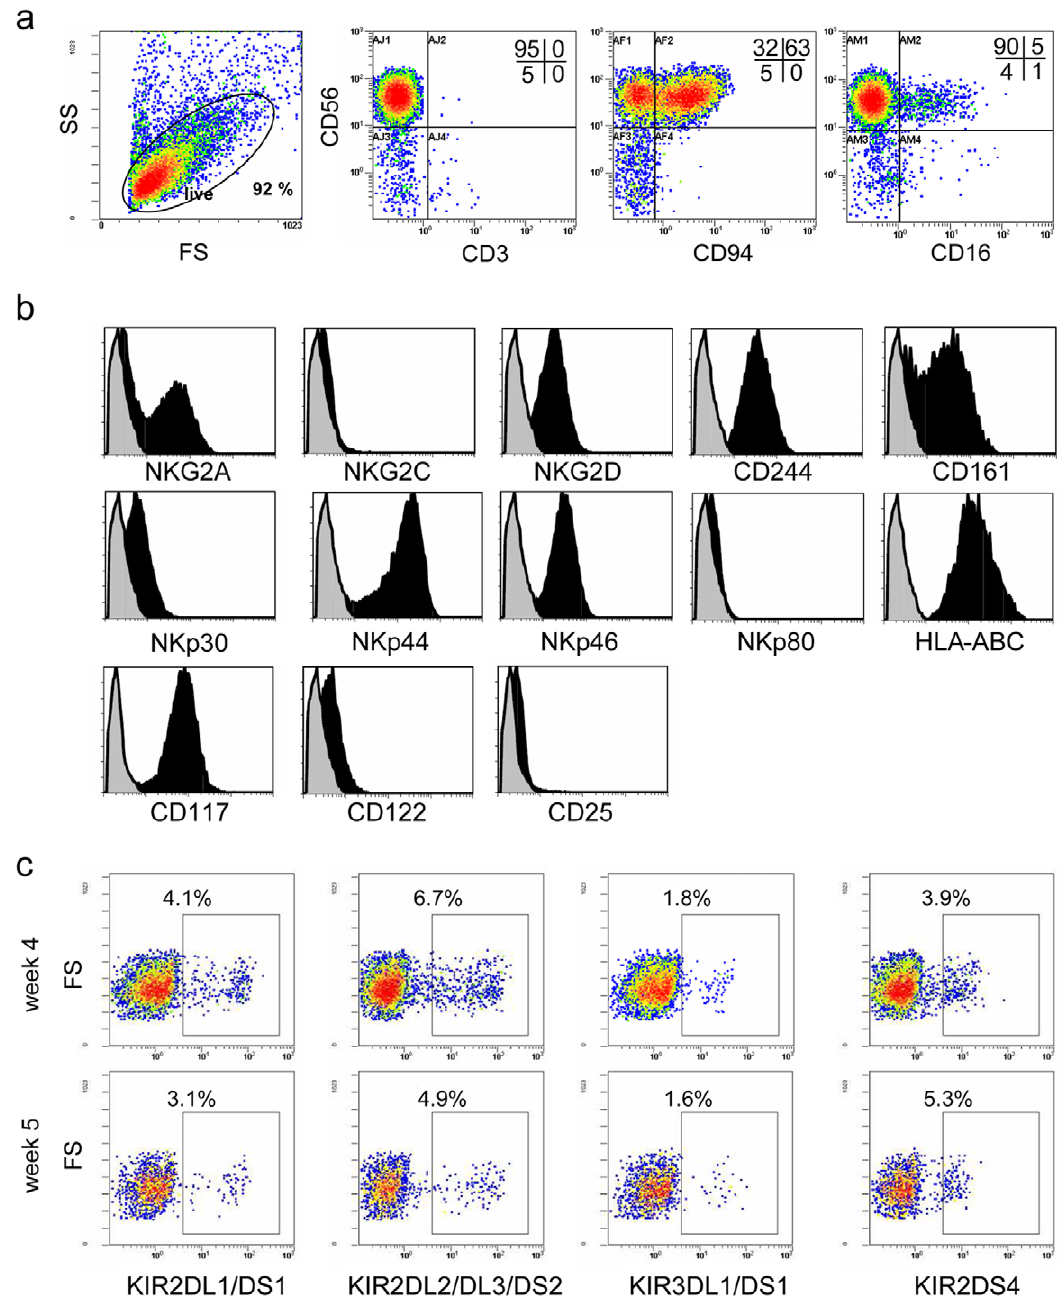
Figure 4. Phenotypical profile of exvivo -generated NK cells using Method II with GBGM. ( a ) Flow cytometric analysis of a representative NK cell product generated from CD34 + UCB progenitor cells. Cells at 5 weeks of culture were analyzed for expression of CD56, CD3, CD94 and CD16. ( b ) Expression of a repertoire of receptors important for regulating NK cell activity, including C-type lectin receptors, natural cytotoxicity receptors and cytokine receptors. Histograms show expression of the antigen of interest (black histogram) compared to the specific isotype control (grey histogram). ( c ) Acquisition of KIR + NK cell subsets during ex vivo NK cell generation from expanded CD34 + UCB cells. KIR expression was determined at week 4 and 5 during the differentiation step by